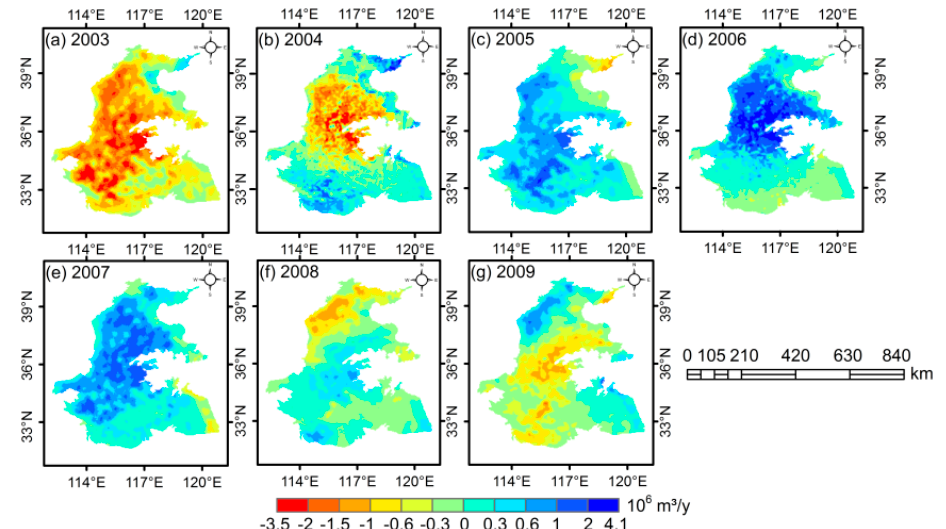
Figure 6. Spatial distribution of WF blue anomalies of wheat in the 3H Plain from 2003 to 2009.